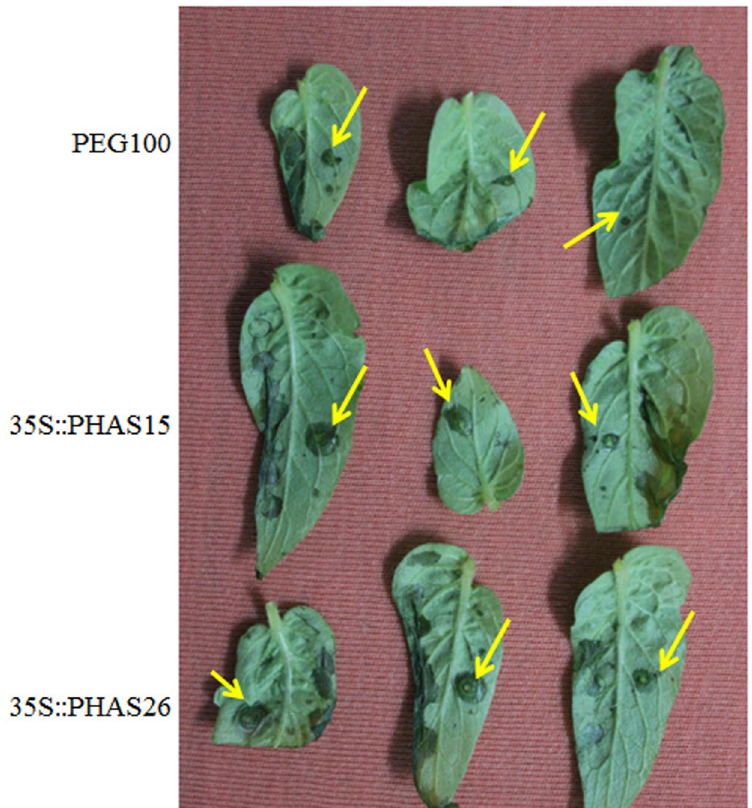
Figure 6. Biological impact of PHAS15 and PHAS26 . Agrobacterium tumefaciens LBA4404 cells containing the overexpression vectors were injected into tomato leaves on one side of the midvein. LBA4404 cells with blank pEG100 vector were also cultured and injected into tomato leaves on one side of the midvein as the control. After 24 h, the opposite sides of the injected leaves were used for inoculation with B. cinerea agar discs (4 mm in diameter) for 48 h. The yellow arrows indicate the inoculation sites of the B. cinerea agar